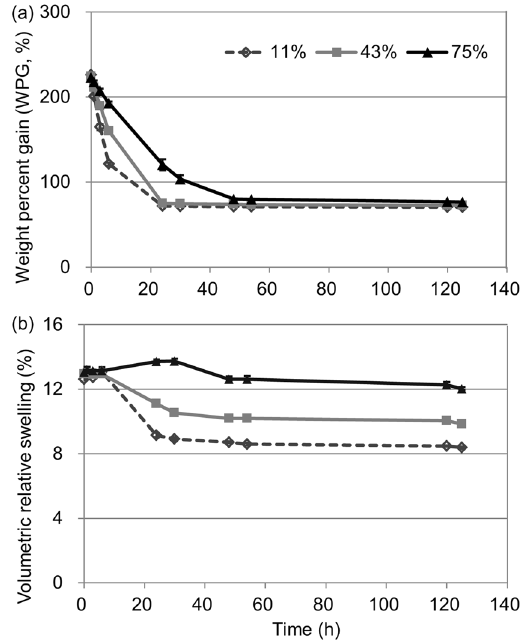
Figure 1. Temporal variability of ( a ) weight percent gain and ( b ) volumetric relative swelling of the MF- impregnated samples conditioned at various RHs (11, 43, and 75%). The bars show the standard deviation from three